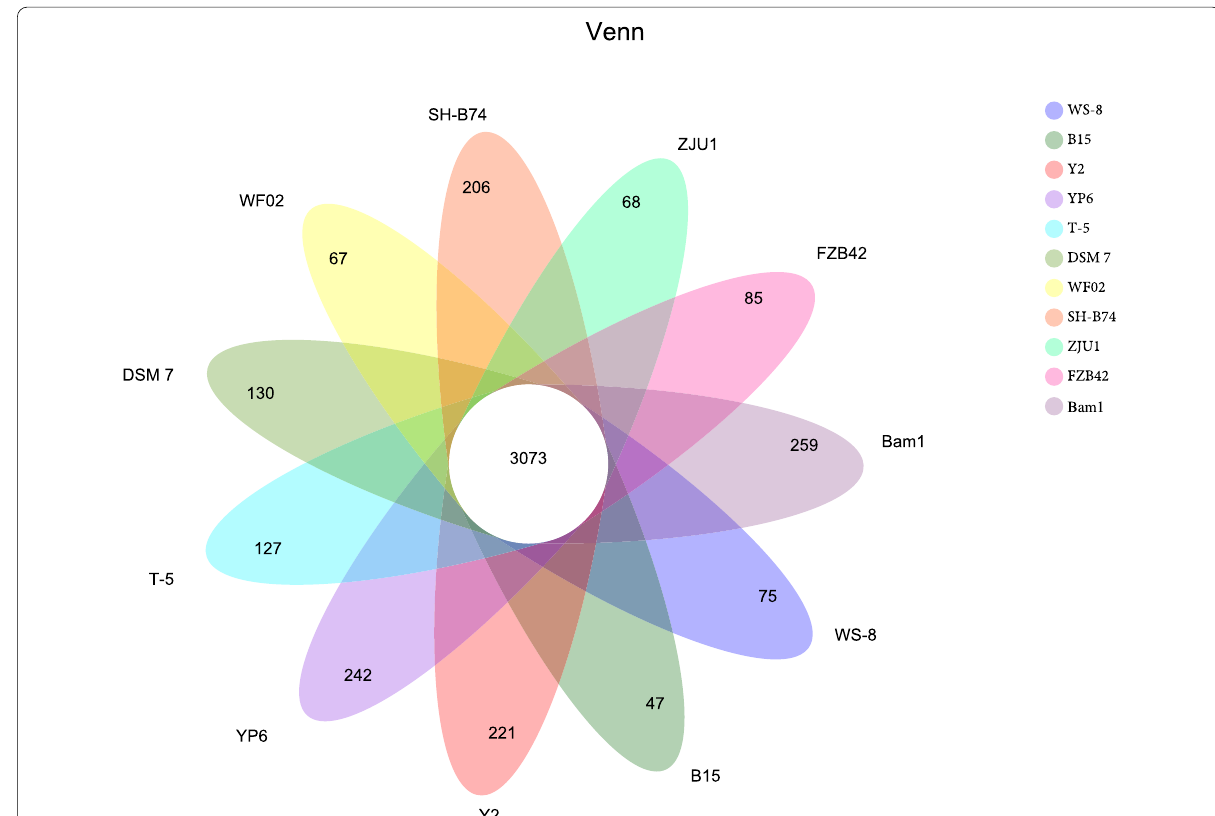
Fig. 4 Venn diagram showing numbers of specific and shared gene families among the ten different B. amyloliquefaciens strains and B. velezensis